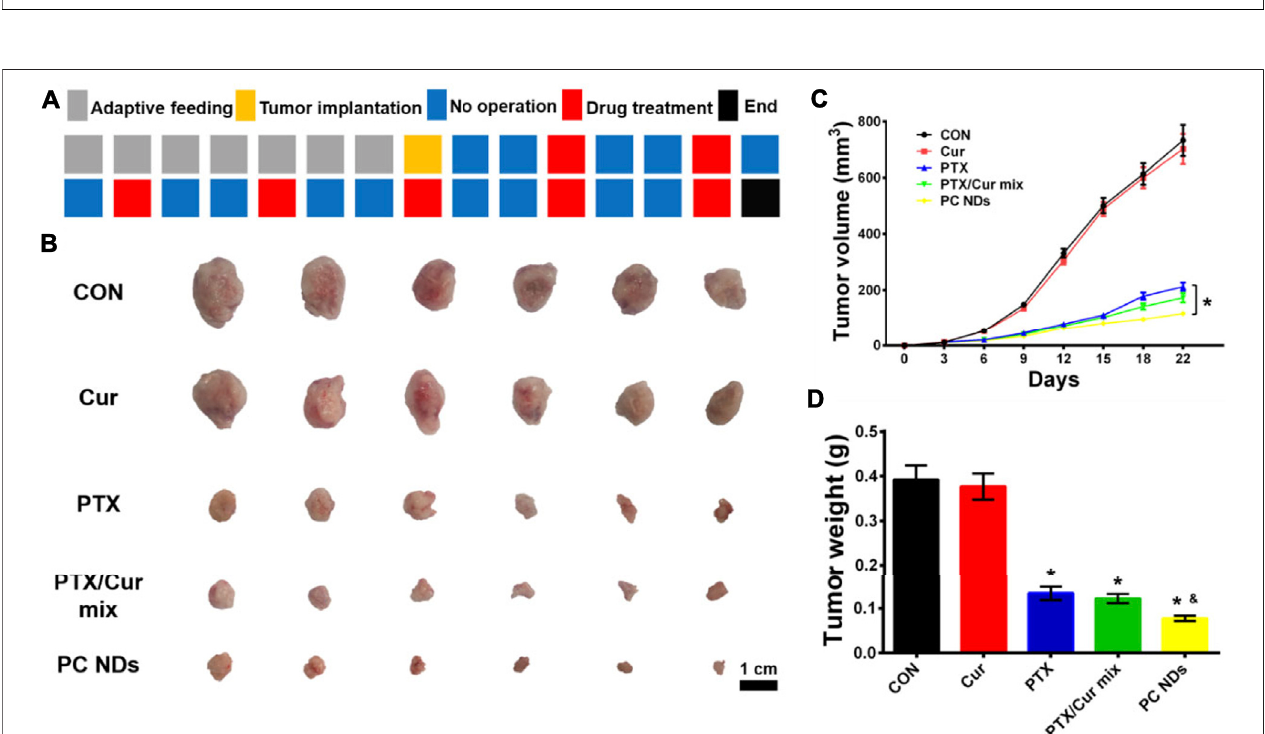
FIGURE5| Invivo anti-TNBCeffectofPCNDs. (A) Dosageregimenoftreatmentfor22 days (B) Tumorimage, (C) Tumorvolume,and (D) tumorweight.Statistical signi fi cance: * p < 0.05 vs PTX in (C) ; * p < 0.05 vs control and p < 0.05 vs PTX in (D) .